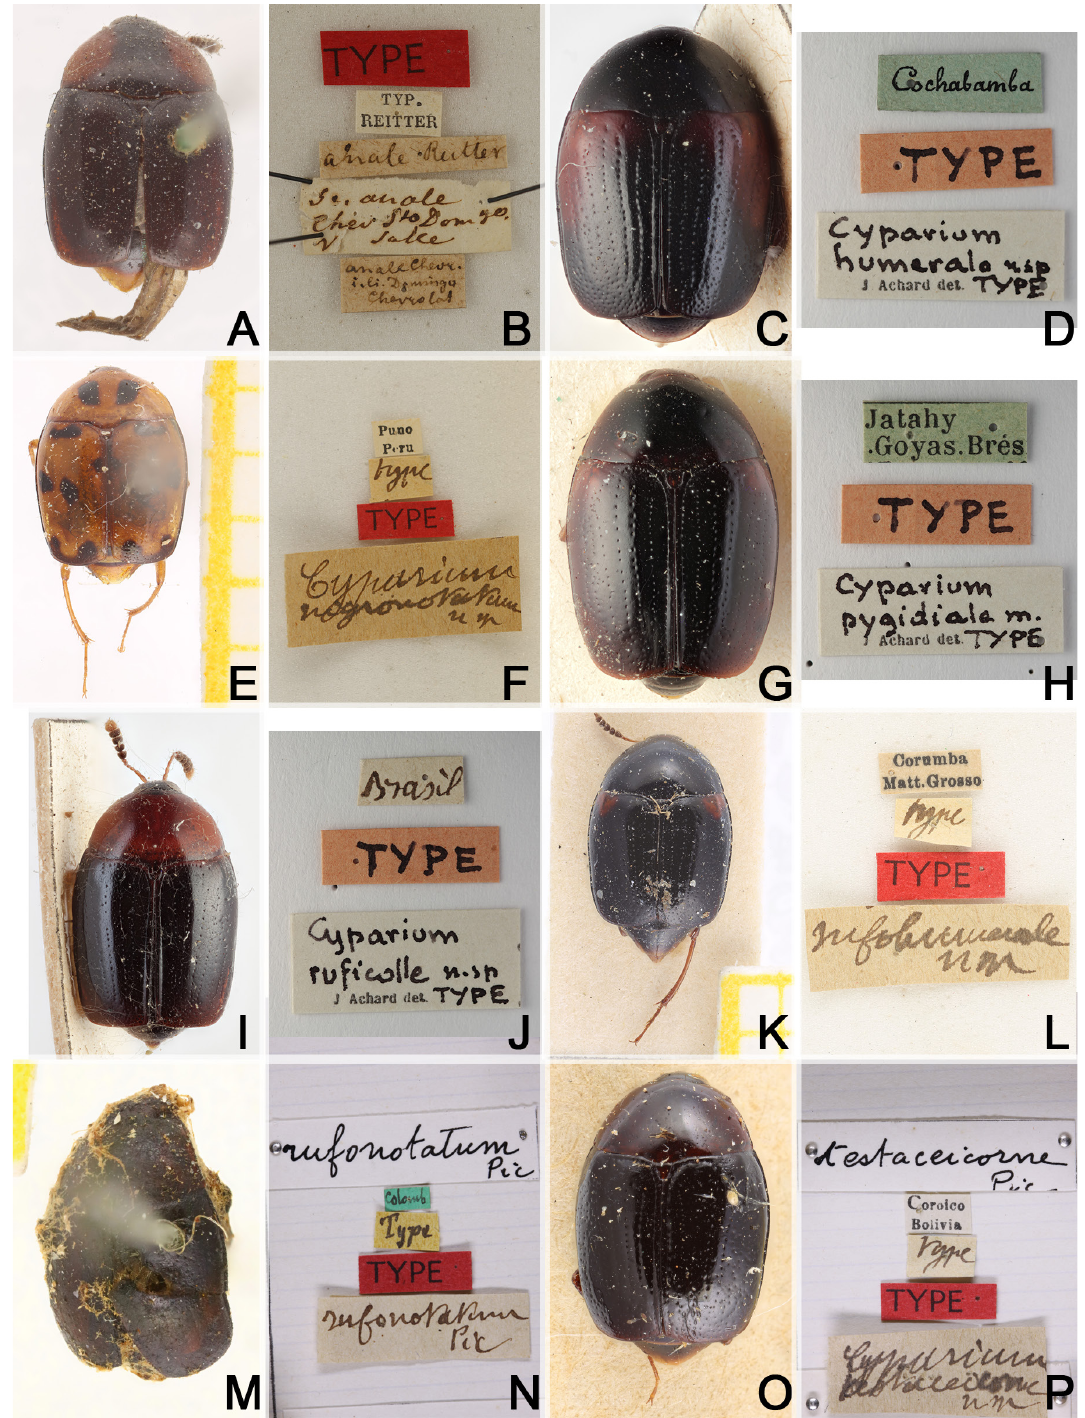
Fig. 6. Syntypes. A–B . Cyparium anale Reitter, 1880 (MNHN). A . Habitus. B . Labels. C–D . C.